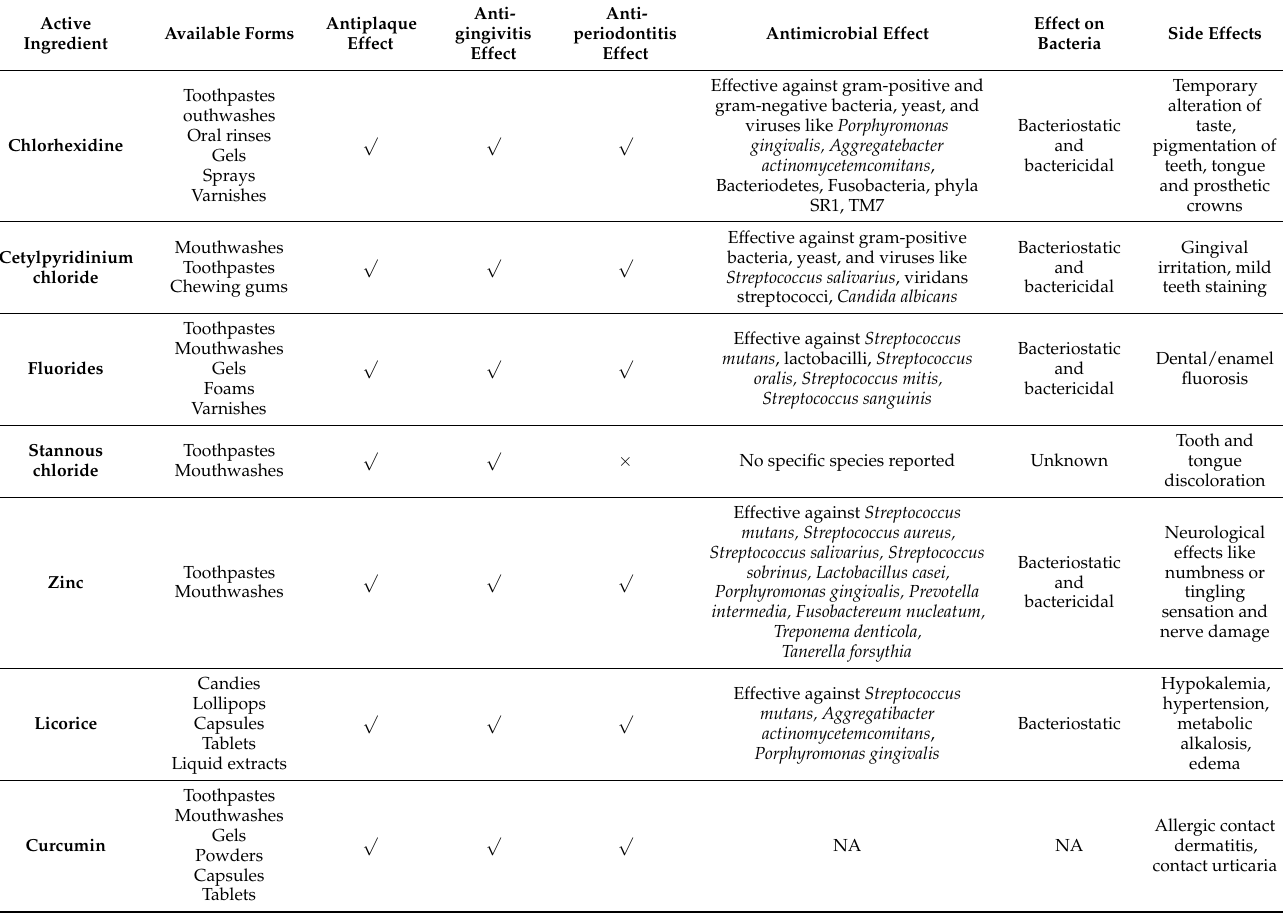
Table 1. Active ingredients in mouthwashes and toothpastes for periodontal